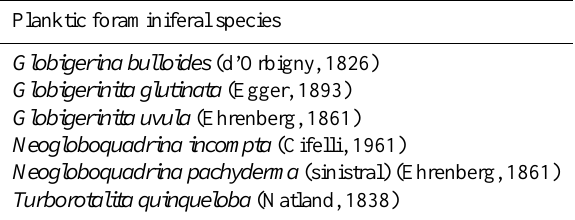
Table 2. Planktic foraminiferal species